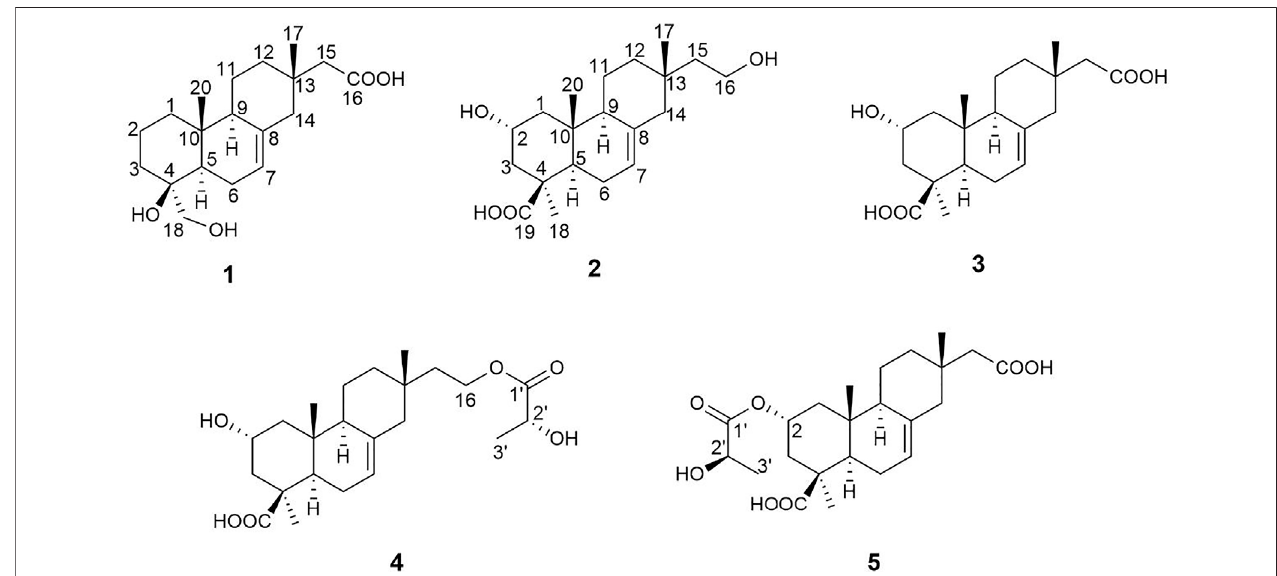
FIGURE 1 | Structures of compounds 1 - 5